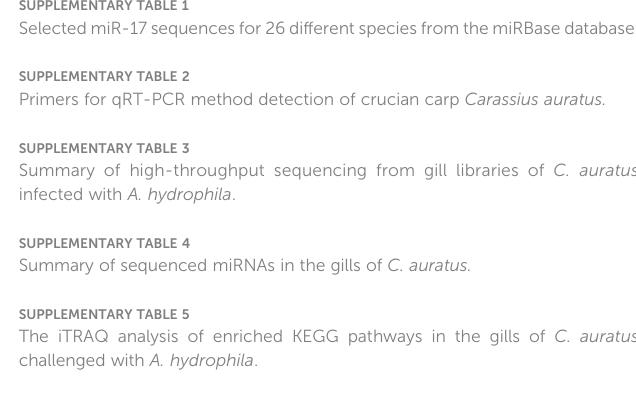
SUPPLEMENTARY FIGURE 1 The multiple sequences alignments of precursor miR-17 sequences. SUPPLEMENTARY FIGURE 2 Cloning analysis of target-gene PI3K in C. auratus . (A) PCR ampli fi cation electrophoresis and positive clone detection. (B) Prediction of PI3K secondary structure. (C) Prediction of PI3K tertiary structure. (D) Phylogenetic tree of PI3K amino acid sequence. M is DNA standard DL 2000 bp; lane 1 is PI3K-1, lane 9 is PI3K-2,lanes2-8arepMD18-TPI3K-1positiveclones,lanes10-13arepMD18-T PI3K-2 positive clones. SUPPLEMENTARY TABLE 1 Selected miR-17 sequences for 26different species from the miRBase database.